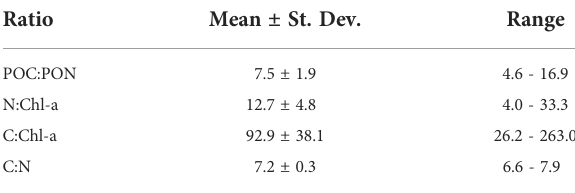
TABLE 2 Mean with standard deviation (St. Dev.) and range of POC: PON, phytoplankton N:Chl-a, C:Chl-a, and C:N, for concurrent data on POC, PON and Chl-a. Ratio Mean ± St.